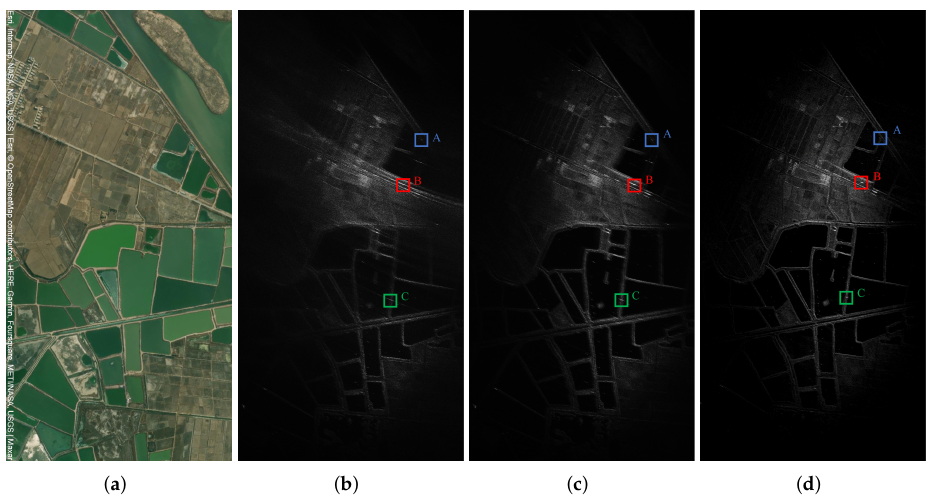
Figure 14. Processing results on the experimental data and scatters selected for analysis: ( a ) op- tical image of the scenario [53]; ( b ) imaging result without motion compensation; ( c ) imaging re- sult with conventional autofocus [25]; ( d ) imaging result with the trajectories estimated by the proposed method.